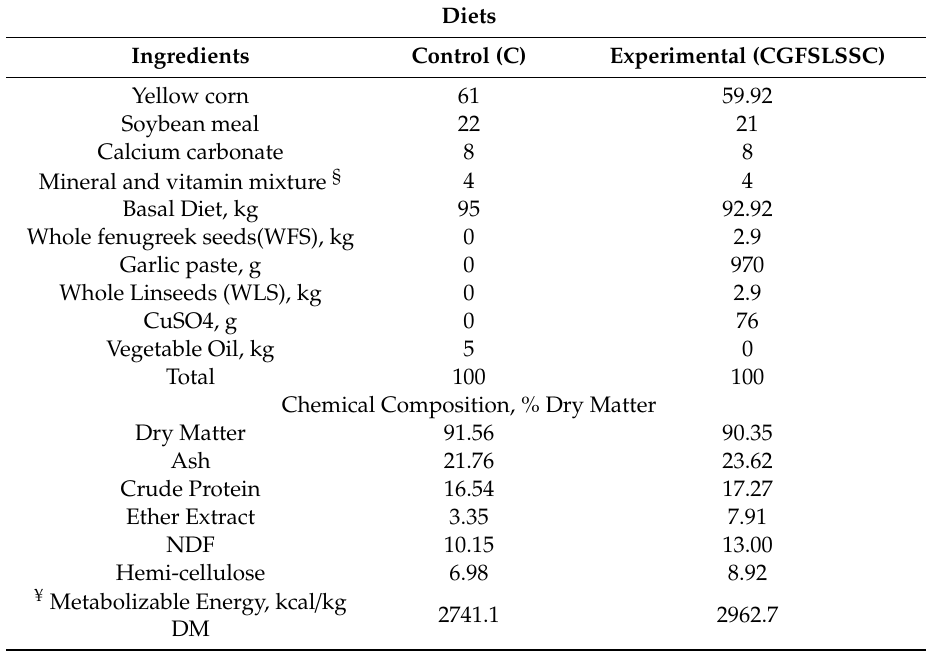
Table 1. Ingredients and calculated o ff ered components of experimental